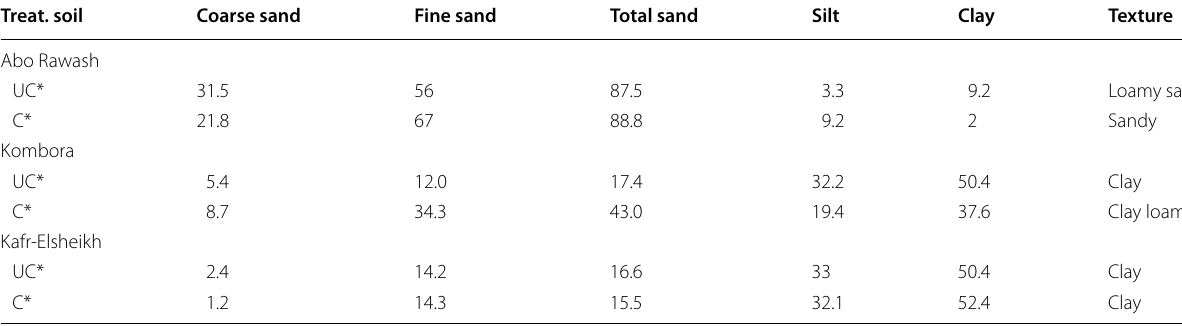
UC uncultivated soil, C cultivated soil Table 3 Total concentrations of potential toxic elements (PTEs) in the studied soils in (mg kg − 1 ) Soil sample